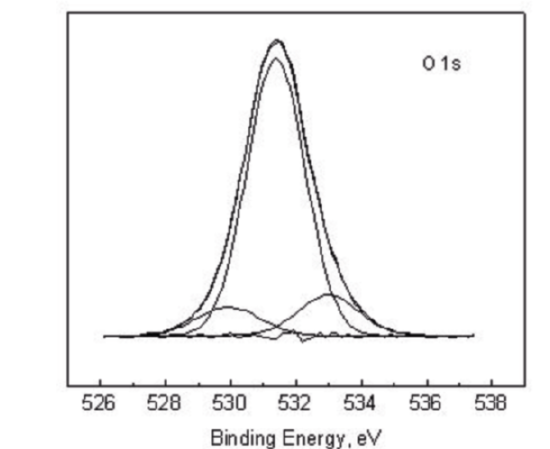
Figure 7. O1s XPS spectrum of sample “Precursor”.